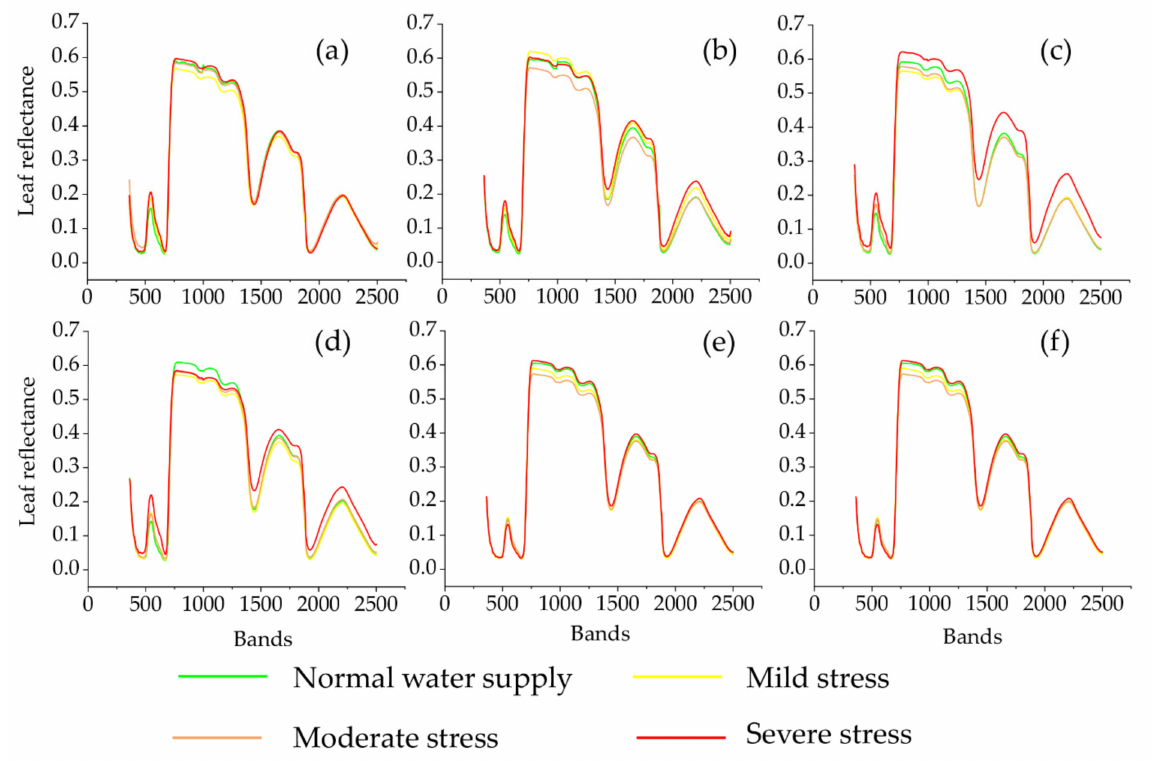
Figure 5. Comparison between the mean spectral reflectance and absorptance at 300–2500 nm for each of the four treatment groups. ( a – f ) represent days 1, 7, 13, 20, 28, and